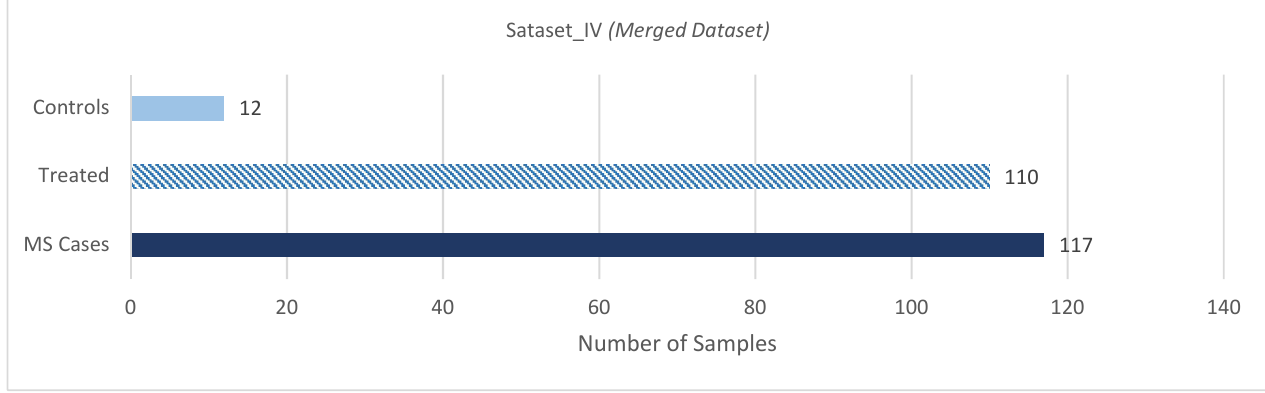
Figure 3. Sample distribution of Dataset_III (MS Disease): (a) 12 controls; (b) 12 MS cases.